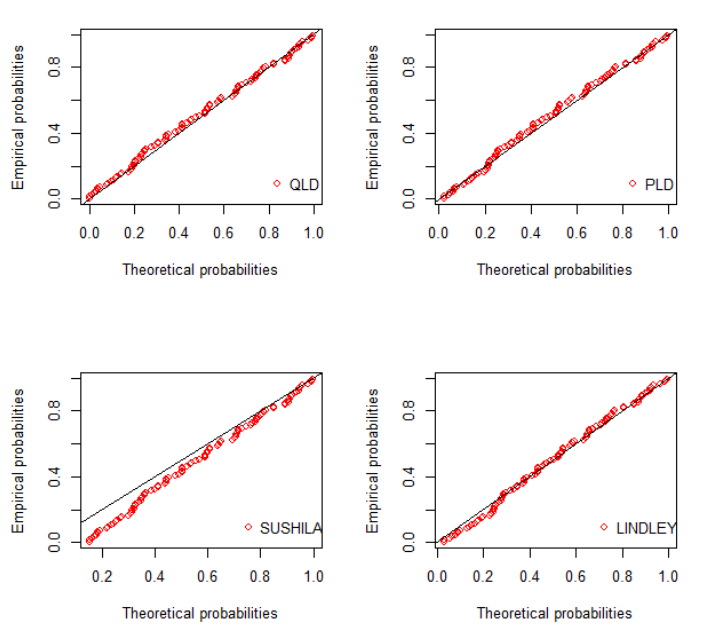
Figure 2 – Probability-Probability plot for the waiting time data. The graphical illustration of the density and cumulative distribution fit and P-P plots of the distributions for the waiting time data is shown in Figures 1 and 2